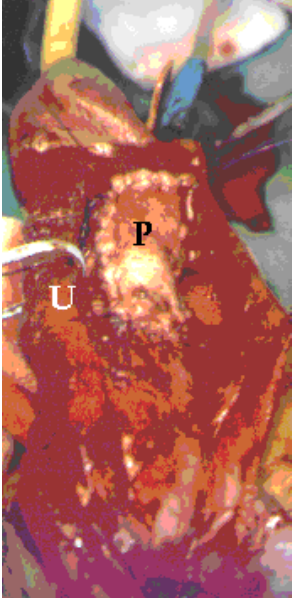
FIGURE 5. In this case the lesion was very large and reconstruction of the corpora was carried out by means of a split thickness dermal graft (P) harvested from the left